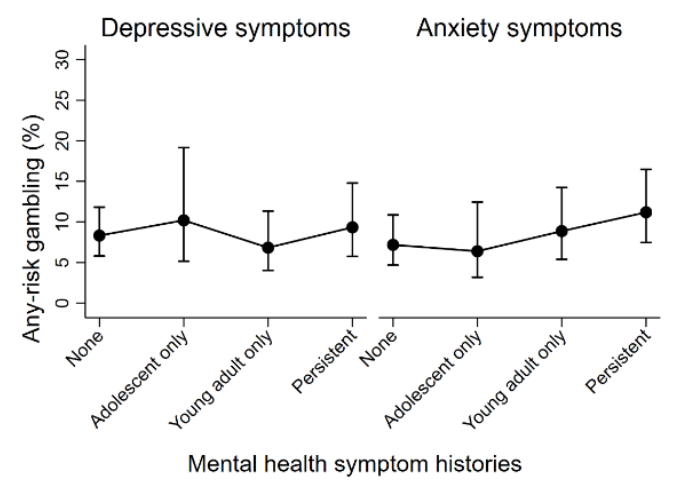
Figure 1. Estimated levels of any-risk gambling across mental health symptom historie.